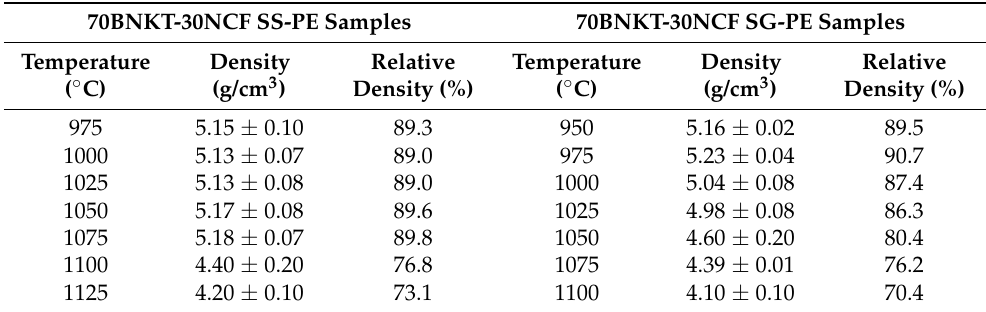
Table 1. Experimental and relative density values of 70BNKT-30NCF (SS-PE and SG-PE) samples sintered at different